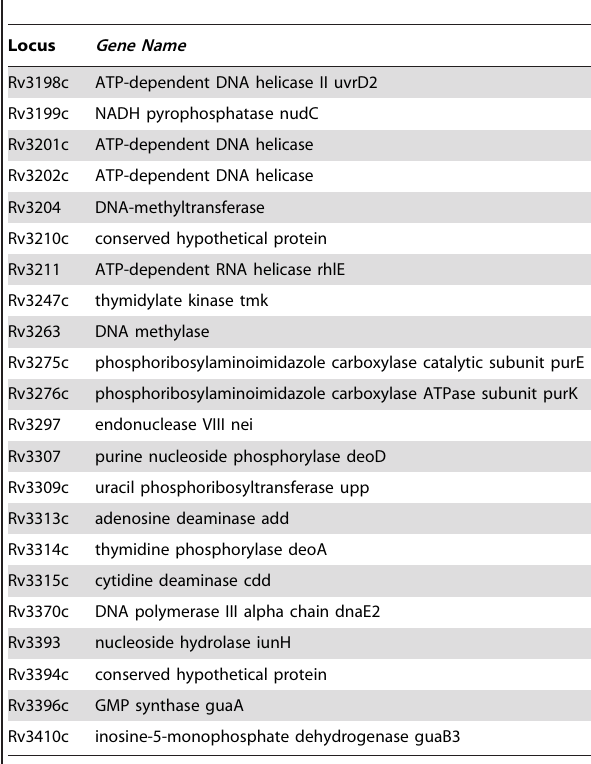
Figure 7. Schematic of duplication boundaries and junctions for CDC606. Color coding is identical to Figure 5 with the exception that genes present in strain CDC606 but missing in the reference genome sequence for H37Rv are colored in red. doi:10.1371/journal.pone.0026038.g007 Table 4. Genes Involved in Nucleotide Metabolism and DNA repair enriched in the intersection of all duplicated